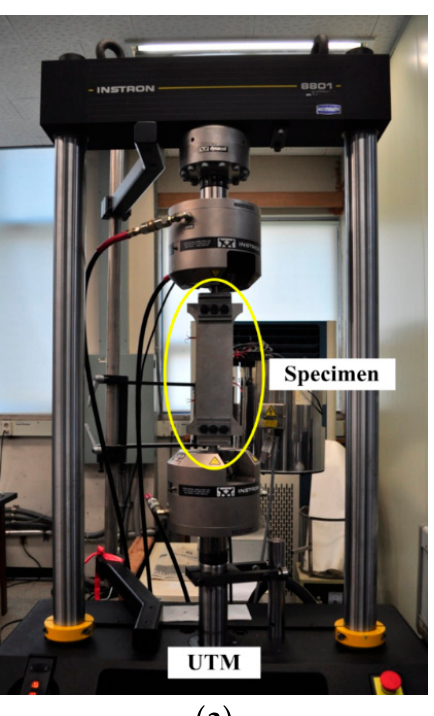
Figure 8. Self-sensing nonlinear ultrasonic system for temperature variation tests. AWG: arbitrary waveform generator; DIG: 14-bit digitizer. Table 3. Test scenarios under temperature variation. Data